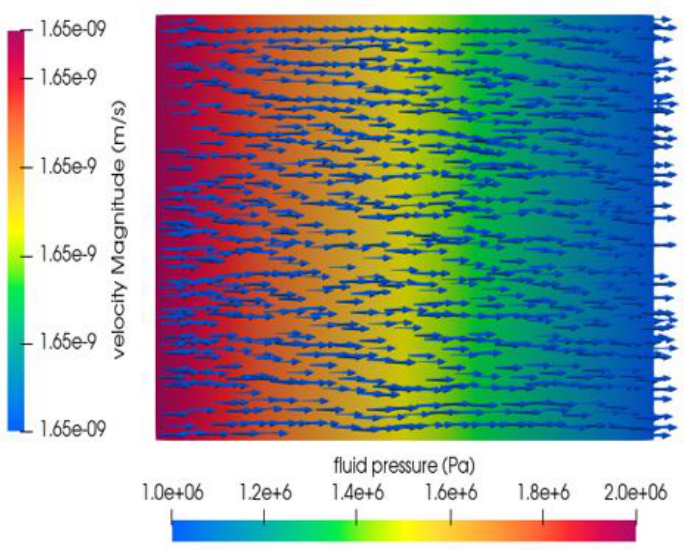
Figure 4. Fluid pressure and velocity field at steady states from the CSMP explicit sequential approach.